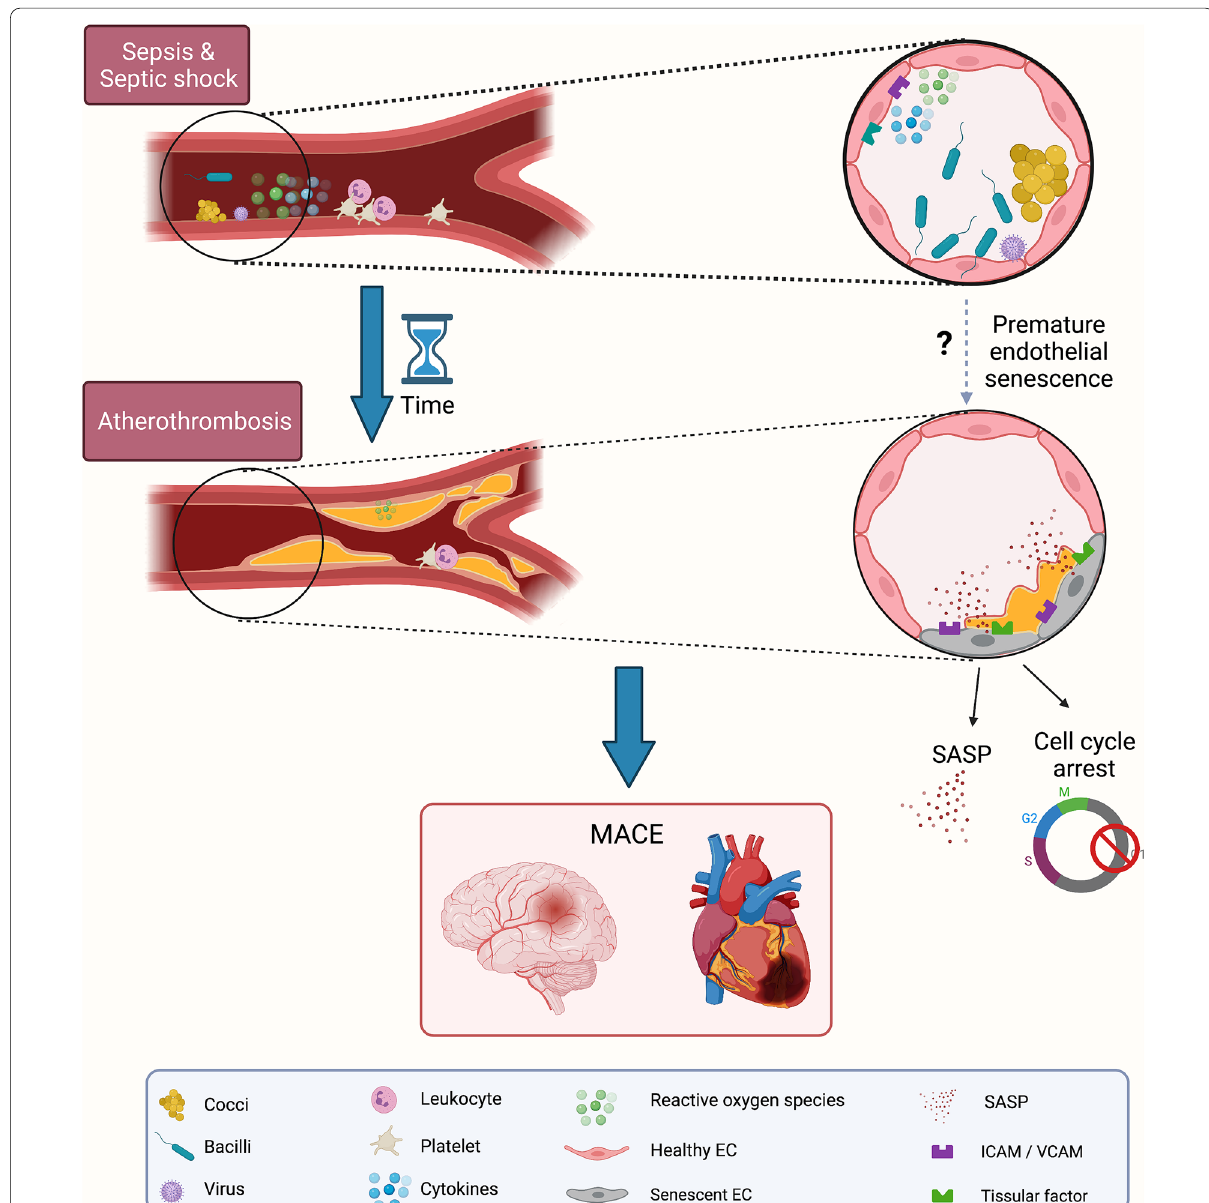
Fig. 1 Potential mechanisms contributing to endothelial senescence‑driven cardiovascular complications after sepsis and septic shock. Sepsis and septic shock survivors have an increased risk of developing cardiovascular events such as myocardial infarction and stroke. Sepsis‑induced premature senescence could explain an accelerated atherogenesis process leading to early major adverse cardiovascular events. SASP senescence‑associated secretory